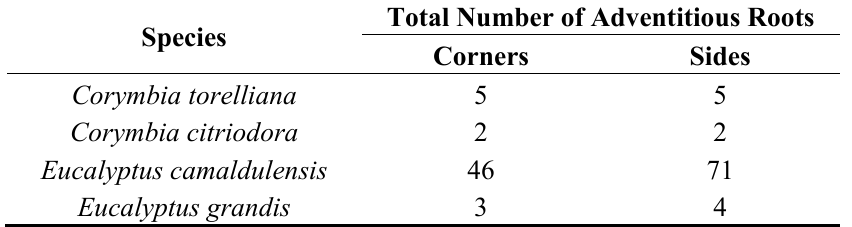
Figure 5. Adventitious root formation and elongation in the base of auxin-treated cuttings from ( a , c , e ) Corymbia torelliana at 21, 14 and 21 days after insertion, respectively, and ( b , d , f ) Eucalyptus camaldulensis at 14, 21 and 28 days after insertion, respectively. Arrows indicate (a,b) root primordia in vascular tissue, (c,d) roots elongating through the cortex, and (e,f) roots elongating through the cortex or emerging through the epidermis. ph = phloem; x = xylem. Scale bars = 100 μm. Table 1. Sites of adventitious root formation (corners or sides of the vascular tissue) identified from transverse sections of the stems of auxin-treated eucalypt